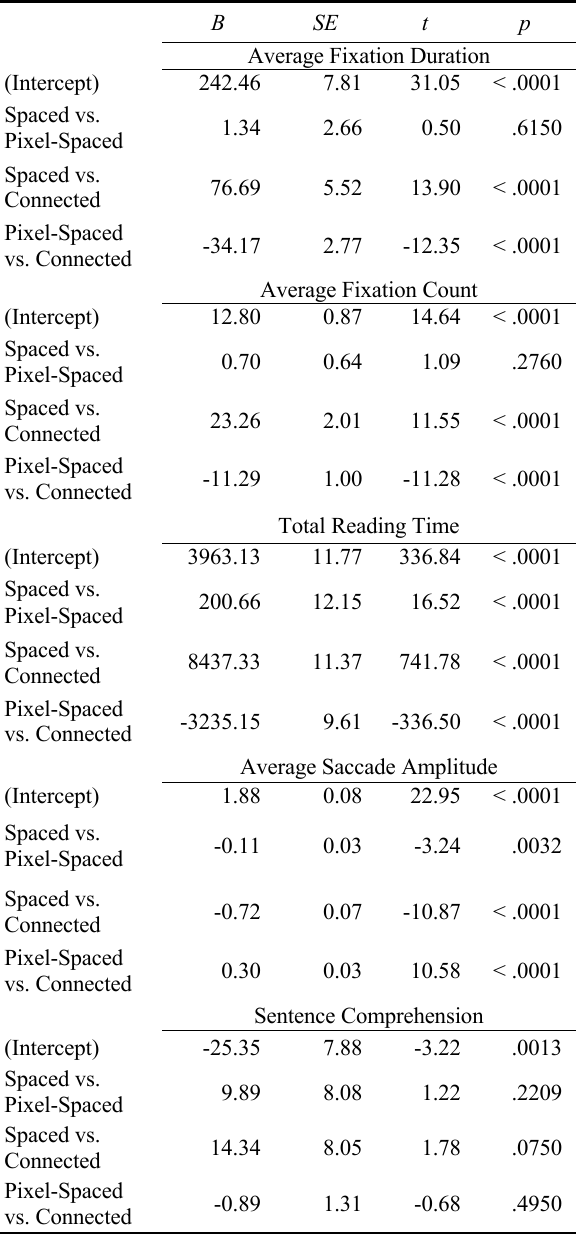
Table 4. Linear Mixed Models Outputs for the Measures Re- ported in Experiment